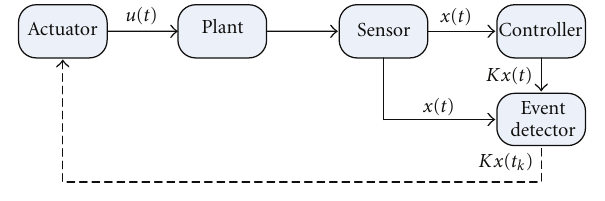
Figure 1: Event-based control